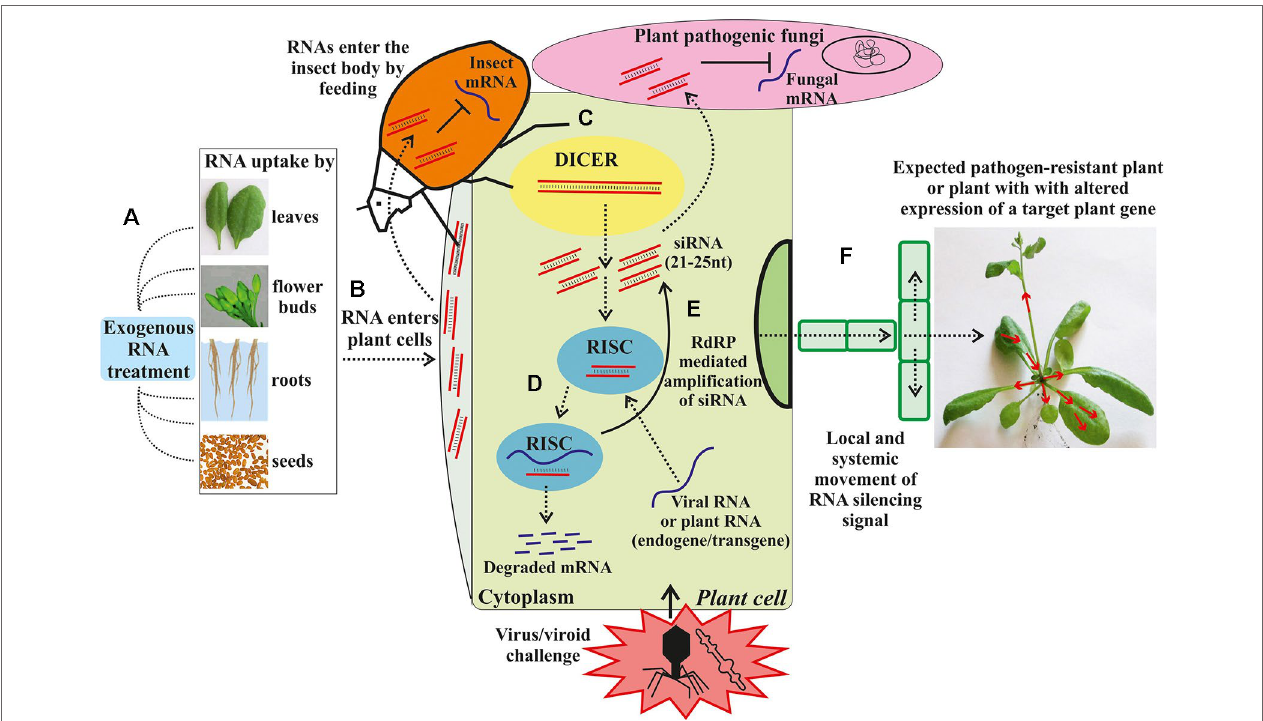
FIGURE 3 | Exogenous RNA applications for RNA interference (RNAi) in plants against biotic stresses. (A) Exogenous artificial RNA application on the plant. (B) The exogenous RNAs transported into the cytoplasm. (C) The dsRNA or hpRNA molecules are recognized by a ribonuclease, DICER-like (DICER), which cleaves the dsRNA into siRNAs. (D) The siRNAs are then incorporated in the RNA-induced silencing complex (RISC) that guides sequence-specific degradation or translational repression of homologous mRNAs. (E) The components of the siRNA/mRNA complex can be amplified into secondary siRNAs by the action of RNA-dependent RNA-polymerase (RdRP). (F) Movement of the RNA silencing signal between plant cells and through the vasculature. Dashed arrows depict different steps of the RNAi induction process and dsRNA/siRNA movement between plant cells and plant pathogens. The solid arrow depicts the RdRP-mediated amplification of siRNA. Red arrows depict the local and systemic movement of the RNA silencing signal in the plant (From Dubrovina and Kiselev,